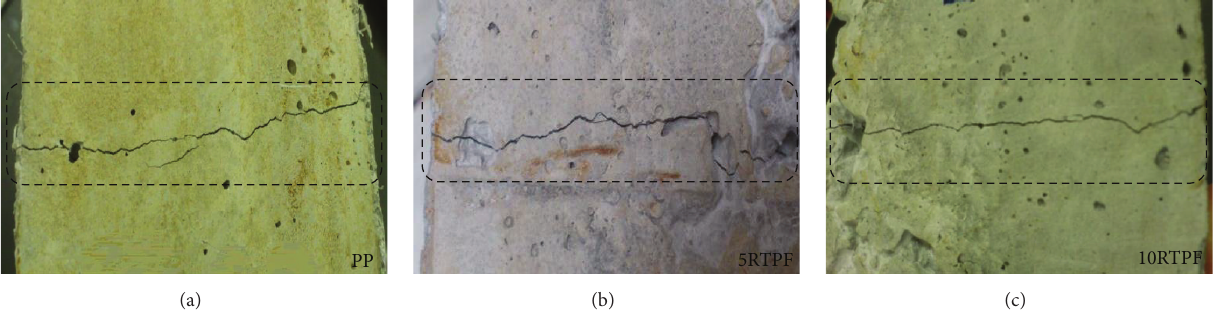
Figure 8: Crack width obtained by visual inspection for mixes: (a) PP, (b) 5RTPF, and (c) 10RTPF.